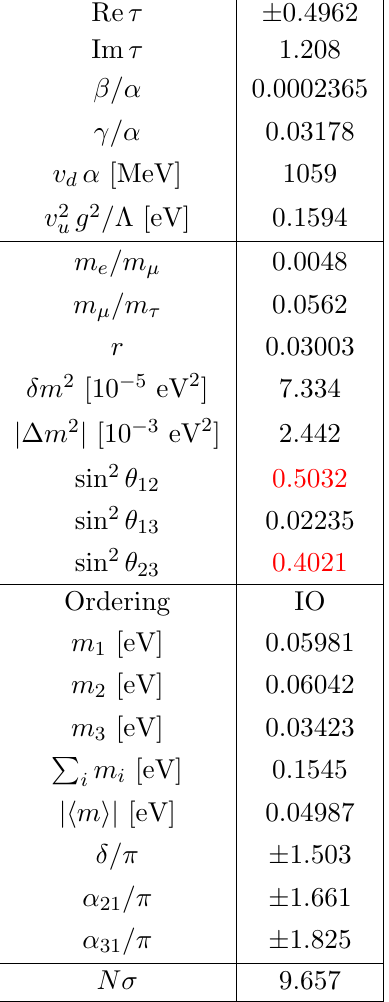
Table 4. Best (cid:12)t values of the parameters and observables in the models with ( k (cid:3) ; k g ) = (2 ; 0). Here and in the following tables the weights ( k (cid:11)